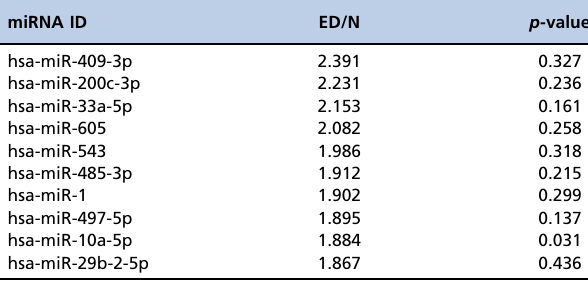
N, healthy controls.